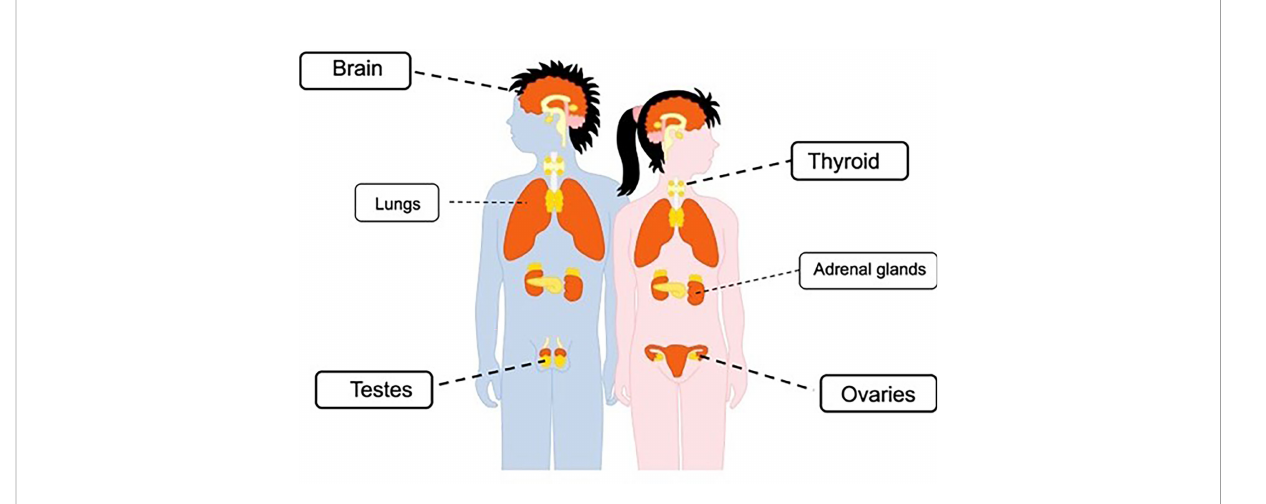
FIGURE 1 Representation of ACE2 expression in endocrine